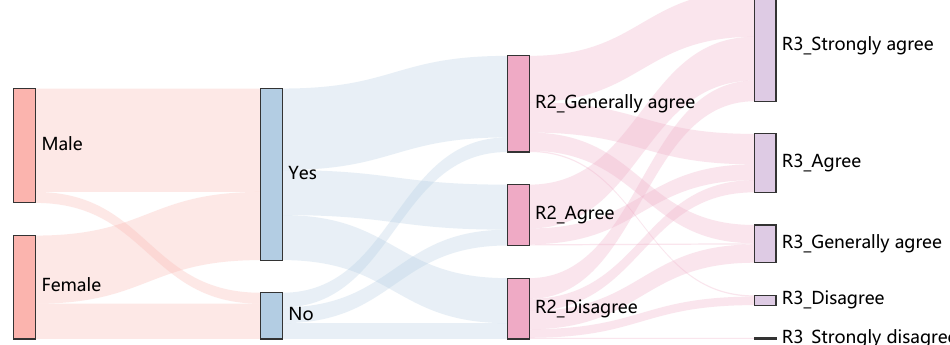
Figure 16. Sankey Diagram results for Mask. The third column shows the distribution of top-3% of user satisfaction, and the fourth column shows the distribution of top-8% of user satisfaction. Mask method is tested with 10 images from DataS and 35 users.